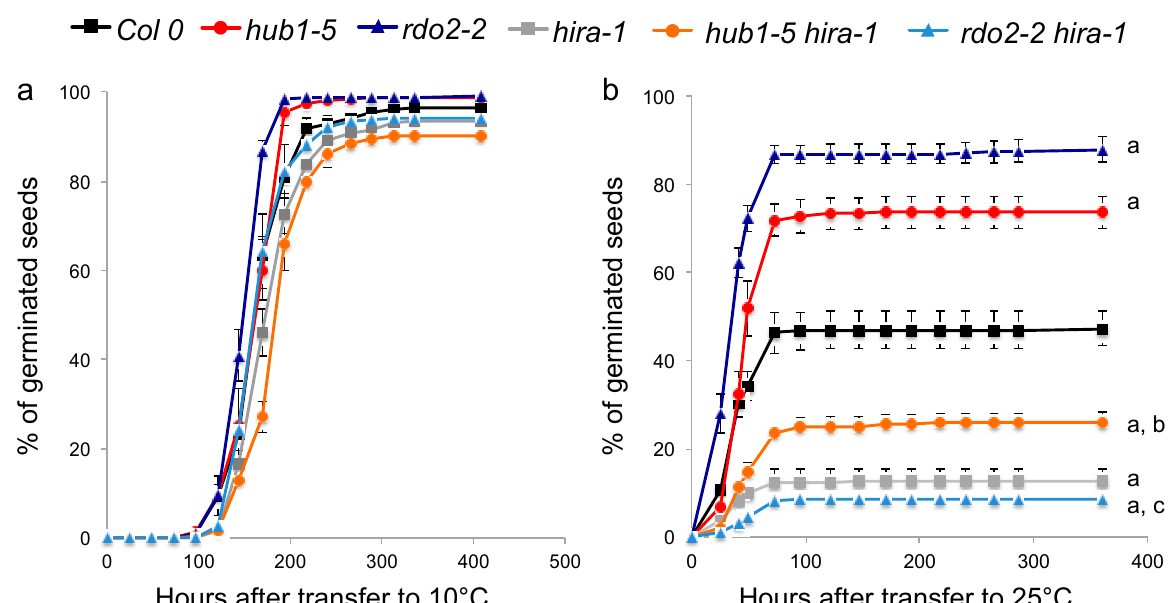
Figure 5. HIRA is epistatic to HUB1 and RDO2/TFIIS . ( a , b ) Germination of freshly harvested seeds of Col 0 (black), hub1-5 (red), rdo2-2 (dark blue), hira-1 (grey), hub1-5 hira-1 (orange) and rdo2-2 hira-1 (light blue) at 10 °C (seed viability test; a ) or at 25 °C (dormancy test; b ) in darkness. Means of biological triplicates with SEM are shown. Statistically significant differences relative to dry seeds were determined using a two-sided Student’s t -test (a = p < 0.01 relative to Col 0; b = p < 0.01 relative to hub1-5 ; c = p < 0.01 relative to rdo2-2 ).